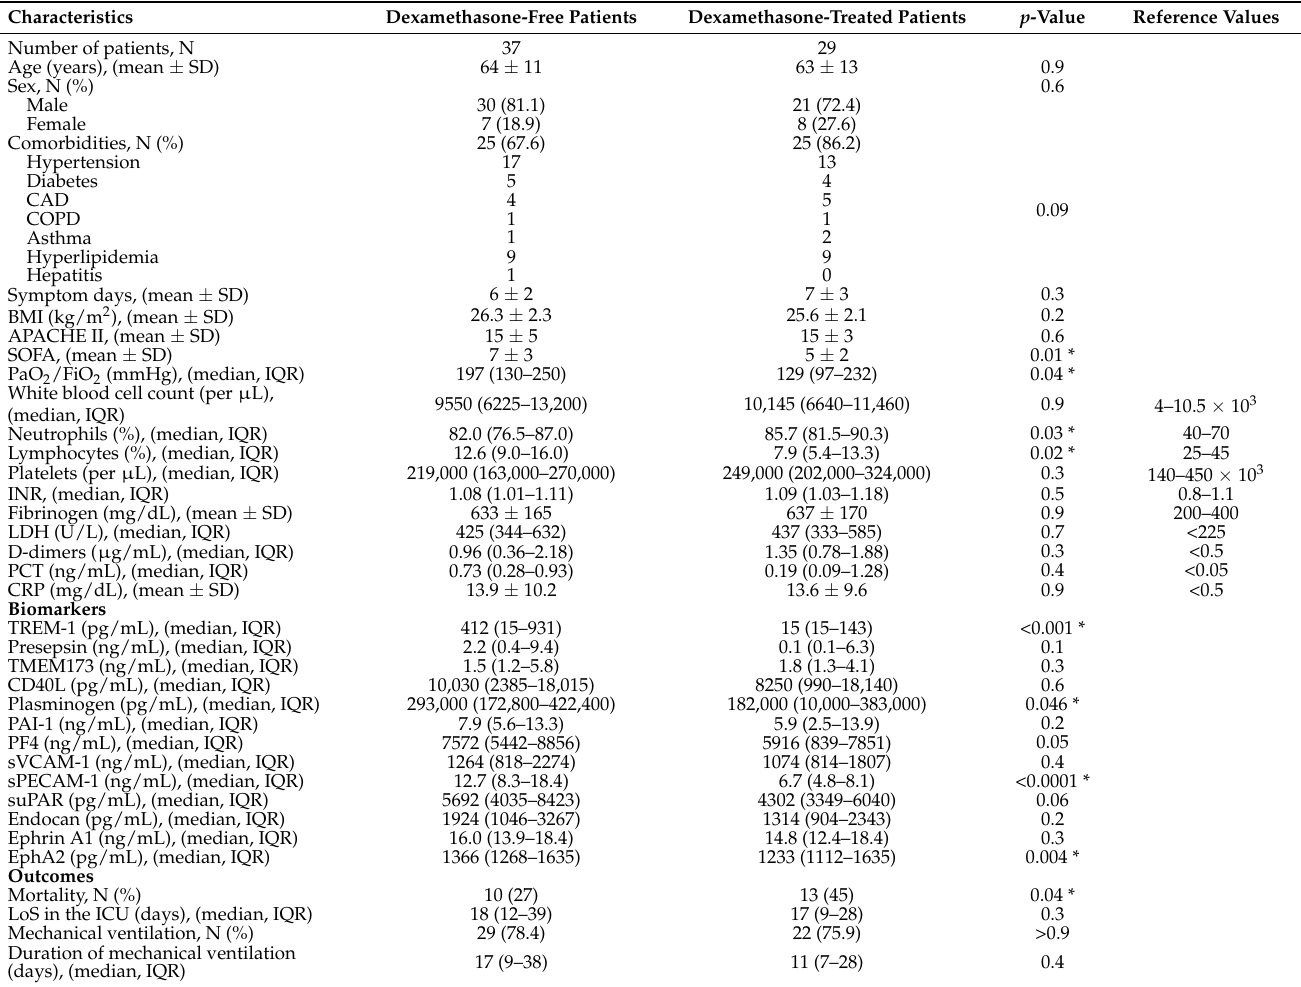
ROC curves were generated to determine the prognostic accuracy of sVCAM-1, suPAR, presepsin, or their combination, in predicting ICU mortality in the dexamethasone-free group; the areas under the curve (AUC) were: 0.87 (95% CI = 0.75–0.99, p < 0.001), 0.95 (0.89–1.01, p < 0.0001), 0.83 (0.69–0.98, p < 0.01), and 0.95 (0.88–1.01, p < 0.0001), respec- tively (Figure 5A). According to the ROC analysis, the optimal cut-off points, and respec- tive sensitivities and specificities for the biomarkers and their combination are given in Figure 5C. The prognostic accuracy of sVCAM-1, suPAR, presepsin, and their combina- tion, following dexamethasone administration, is shown in Figure 5B; the AUCs were: 0.73 (95% CI = 0.53–0.93, p < 0.05), 0.85 (0.70–0.99, p < 0.01), 0.84 (0.68–1.00, p < 0.01), and 0.95 (0.88–1.02, p < 0.0001), respectively (Figure 5B). The optimal cut-off points and re- spective sensitivities and specificities for the biomarkers and their combination are given in Figure 5D. Table 1. Demographics, clinical characteristics, and biomarkers on ICU admission, and ICU-related parameters.